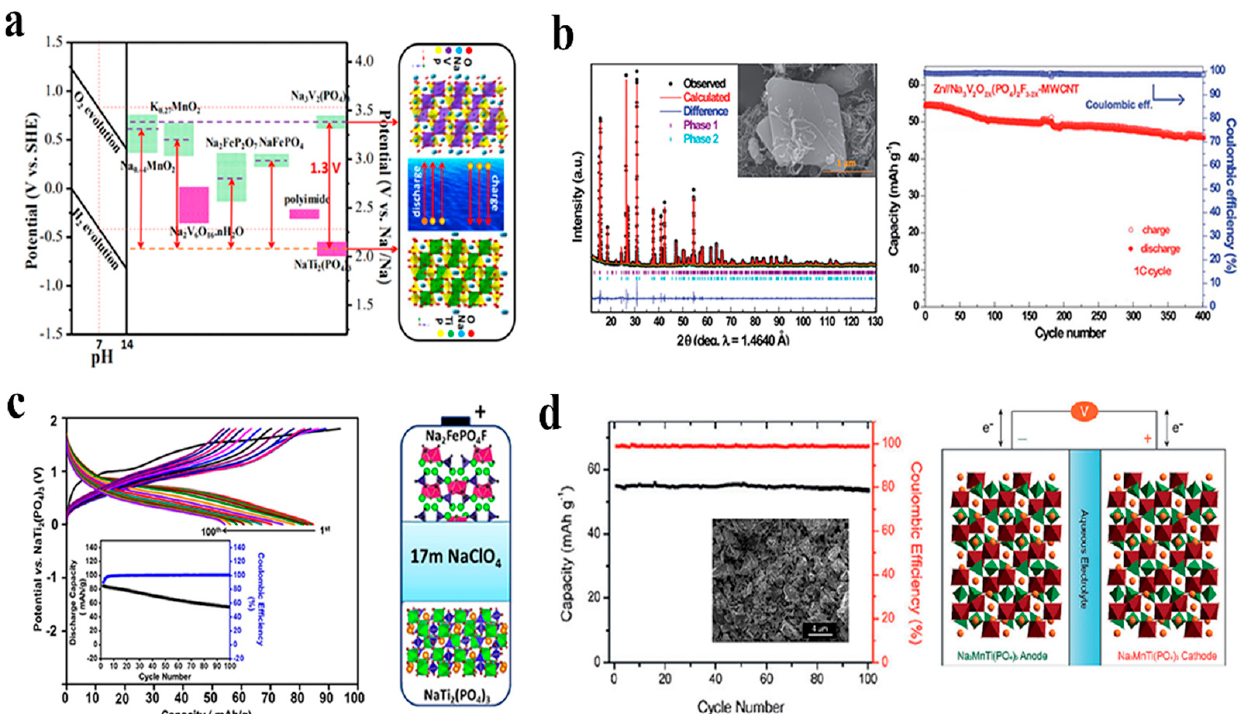
Figure 5. ( a ) Comparison of NaTi 2 (PO 4 ) 3 and Na 3 V 2 (PO 4 ) 3 with other electrode materials used in ASIBs. Reproduced with the permission of ref. [24], copyright 2016 Elsevier Ltd. ( b ) The XRD data for the composite with cycling performance and coulombic efficiencies of the full cell. Reproduced with the permission of ref. [25], copyright 2015 The Royal Society of Chemistry ( c ) The galvanostatic potential-capacity profiles with inserted capacity retention and coulombic efficiency of the aqueous full cell at 25 ◦ C up to 100 cycles.. Reproduced with the permission of ref. [52], copyright 2018 Wiley − VCH Verlag GmbH & Co. KGaA, Weinheim. ( d ) Schematic illustration of the full battery with capacity retention and coulombic efficiency at a rate of 1 C.. Reproduced with the permission